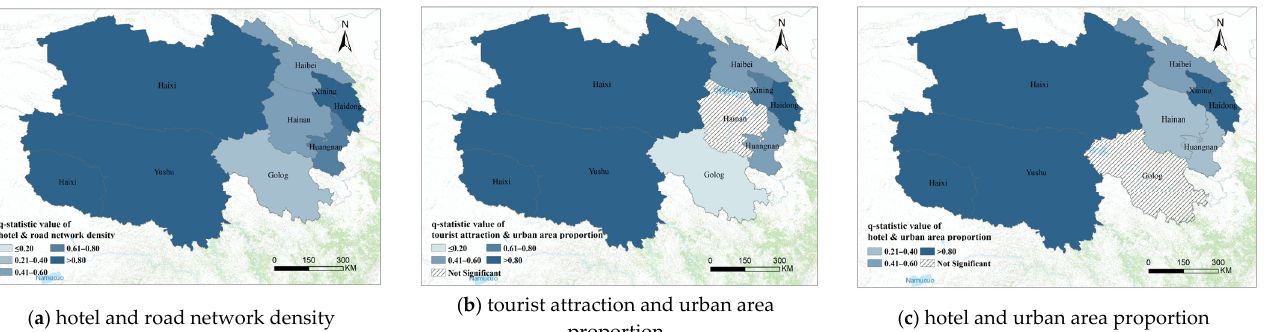
Figure 8. q -statistics of factors by city in Qinghai Figure 8. q -Statistics of factors by city in Qinghai.